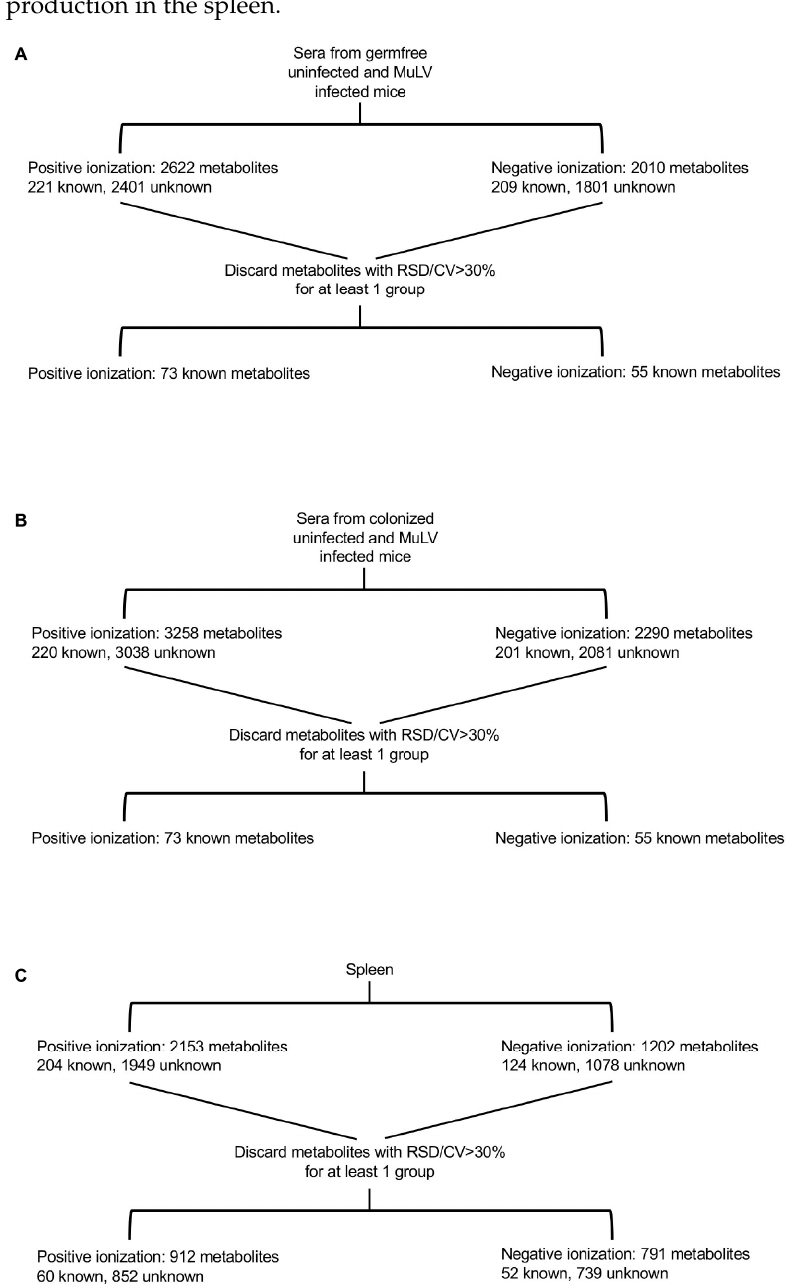
Figure 1. Flow chart illustrating the processing of sera and spleen samples for metabolomics. Mass spectrometry for serum samples was conducted in two separate procedures ( A , B ). Therefore, unknown metabolites could not be matched between the experiments and were removed. Spleen ( C ) samples were subjected to mass spectrometry under positive and negative ionization modes. Metabolites within a cohort of mice with a relative standard deviation (RSD) > 30% between technical replicates were discarded, leaving the indicated number of known and unknown metabolites.